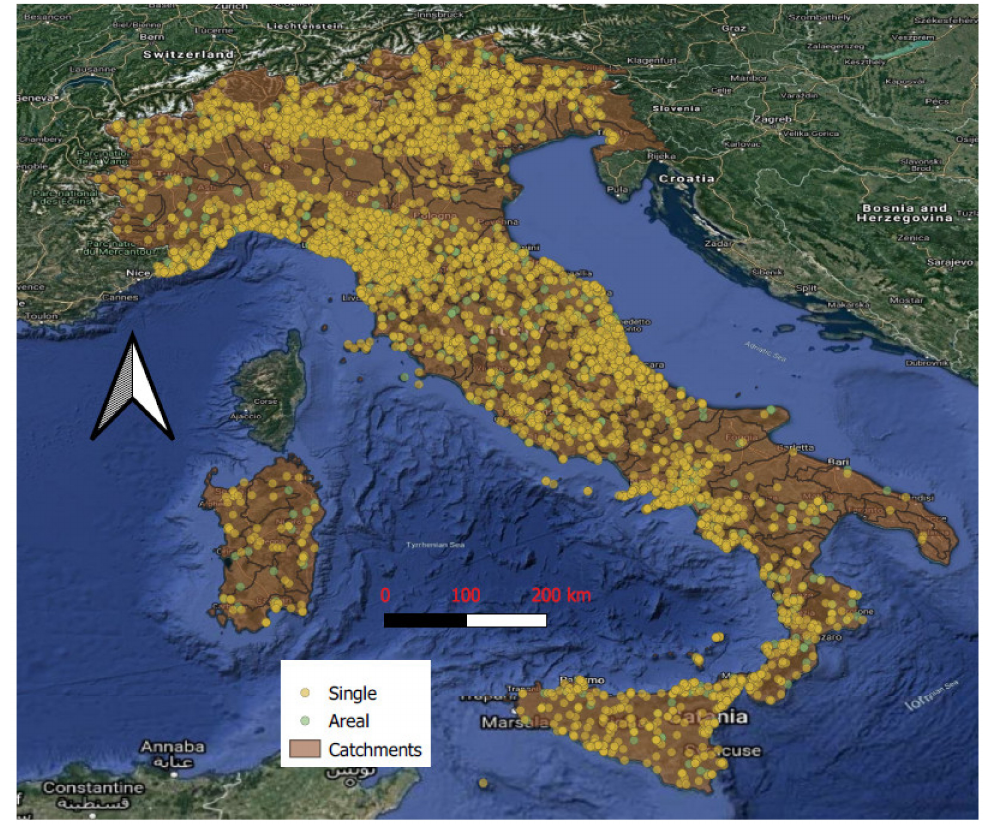
Figure 1. Location of all landslides used (FraneItalia database) and HydroSheds catchments bound- aries (i.e., 7th level) that were used to test the added value of soil moisture data at regional